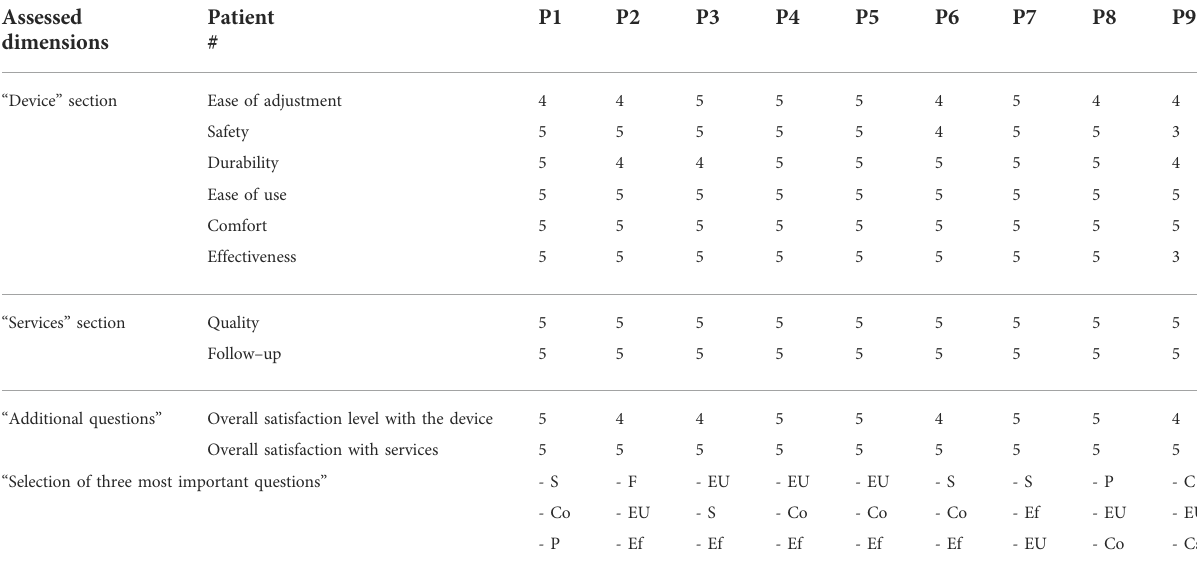
TABLE 6 Results of the QUEST